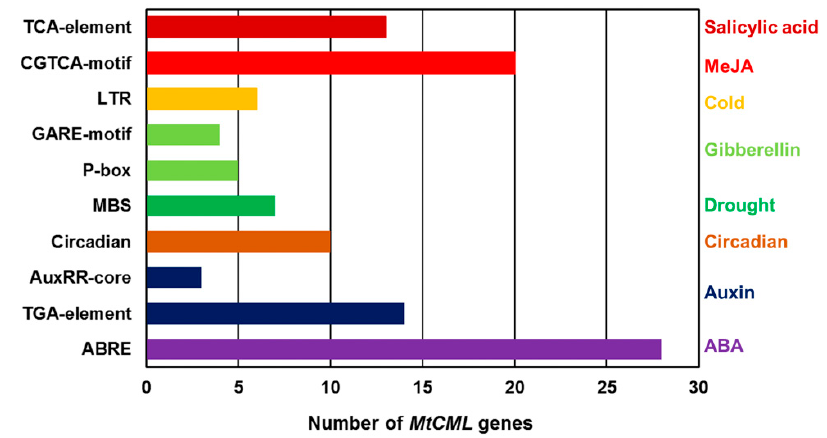
Figure 5. Number of MtCML genes containing various cis -acting elements. ABRE, ABA-responsive element. LTR— cis -acting element involved in low-temperature response; CGTCA-motif— cis -acting element involved in MeJA response; TCA-element— cis -acting element involved in SA response; GARE-motif and P- box— cis -acting element involved in GA response; MBS— cis -acting element involved in drought response; circadin— cis -acting element involved in biologic rhythms; AuxRR-core and TGA-element— cis -acting elements involved in auxin response.